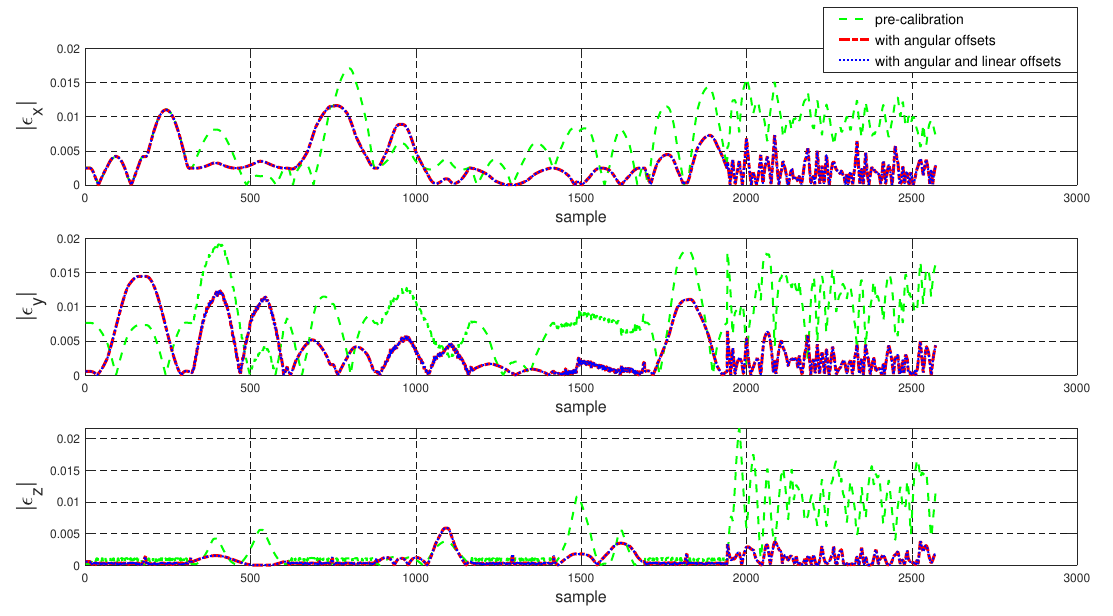
Figure 11. Resultant end-effector position error for the training set before and after calibration. The error corresponding to the additional training data starts at sample number 1940.